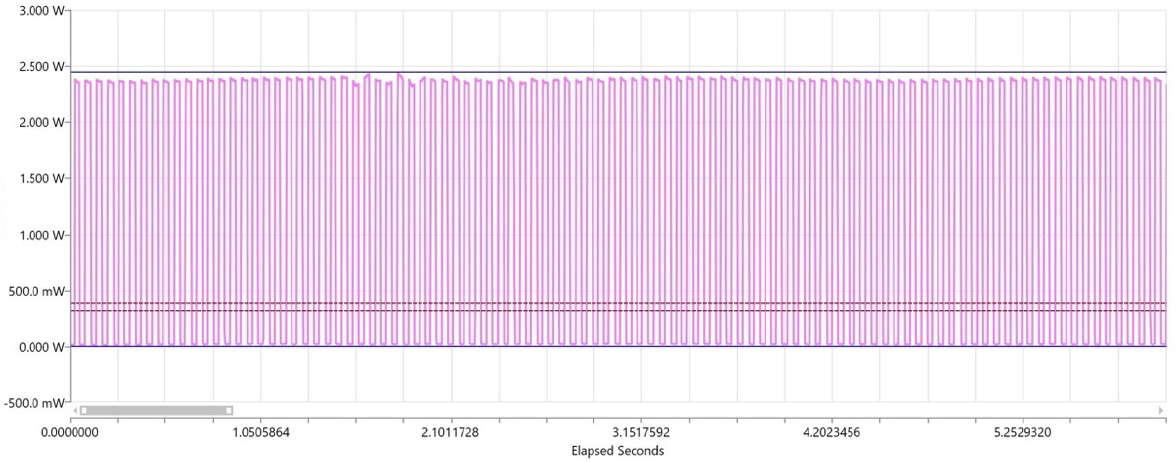
Figure 6. Representative power output of Picasso (810 nm) in pulsed mode over 5 s.